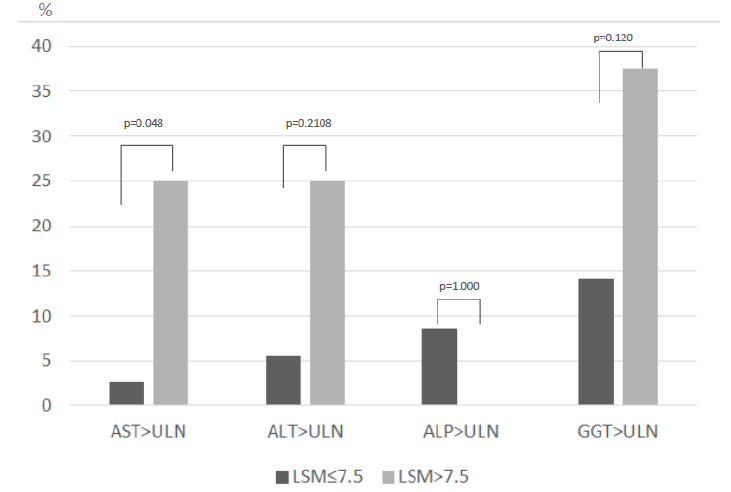
Figure 2. All individuals from the cohort with liver enzymes above the highest level of normal based on LSM values. UPN: Upper limit of normal for GGT: >38 IU/L in females and >55 IU/L in males.